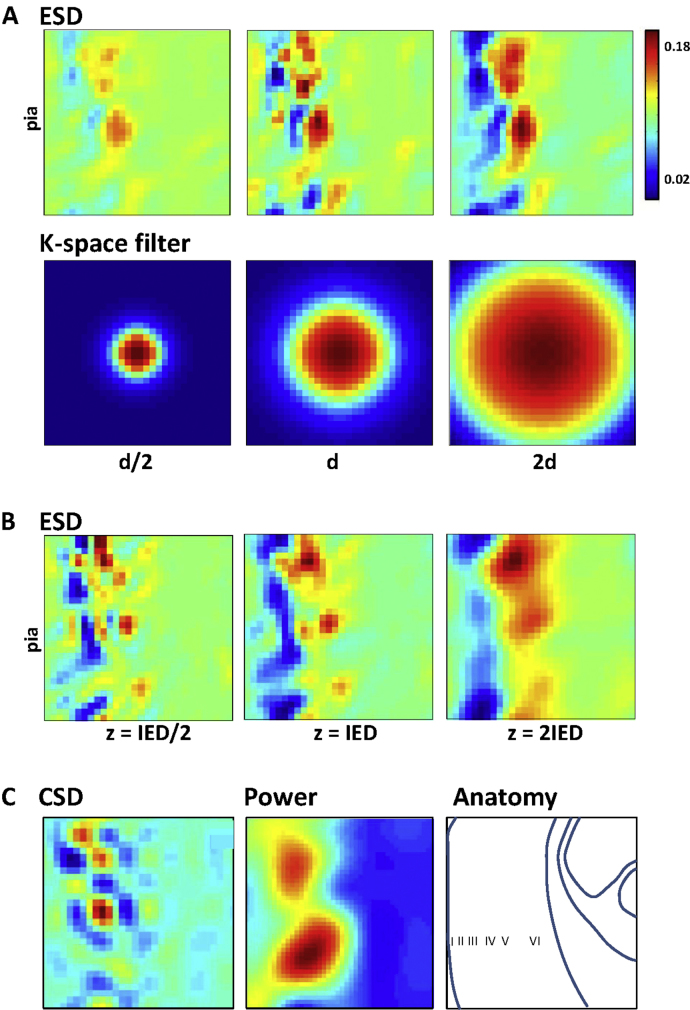
Effects of k-space filter width and recording/reconstruction plane separation on estimated energy source density structure. (A) Energy source density (ESD) maps for different k-space filter widths (d). Note ESD is the electromagnetic correlate of current source density and is generated from the divergence of the Poynting vector. The degree of spatial detail increases with finer spatial filtering until reconstructed activity begins to disappear into noise. (B) The spatial scale at which this occurs is dependent on the relative values of interelectrode distance (IED) and distance from recording to reconstruction plane (z). (C) Comparison with conventional activity maps. Current source density (CSD) reveals discrete source/sink loci but fails to capture the laminar organisation of the delta rhythm-related activity. Power maps (raw delta power from Fourier transform of the recorded voltage signal per electrode) reveal the deep layer domination of this activity but not the overt laminar differences revealed by ESD. Right panel shows a crude representation of the cortical anatomy within which the activity is recorded/reconstructed.